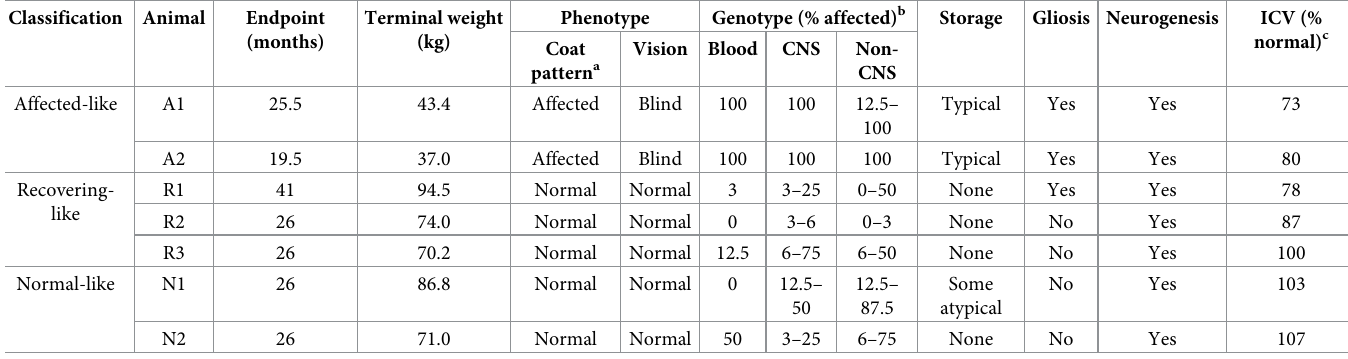
Table 2. Phenotypic, genotypic and histological status of chimeric animals. Classification